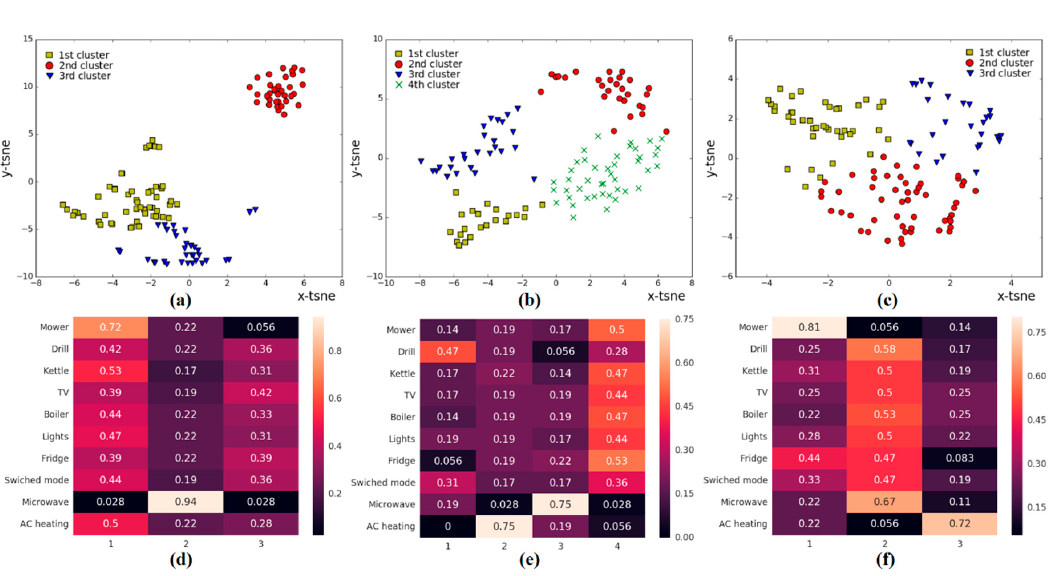
Table 9. Mutual information estimated among the appliance features and cluster labels derived from PQ parameters measured at SoC 50%.